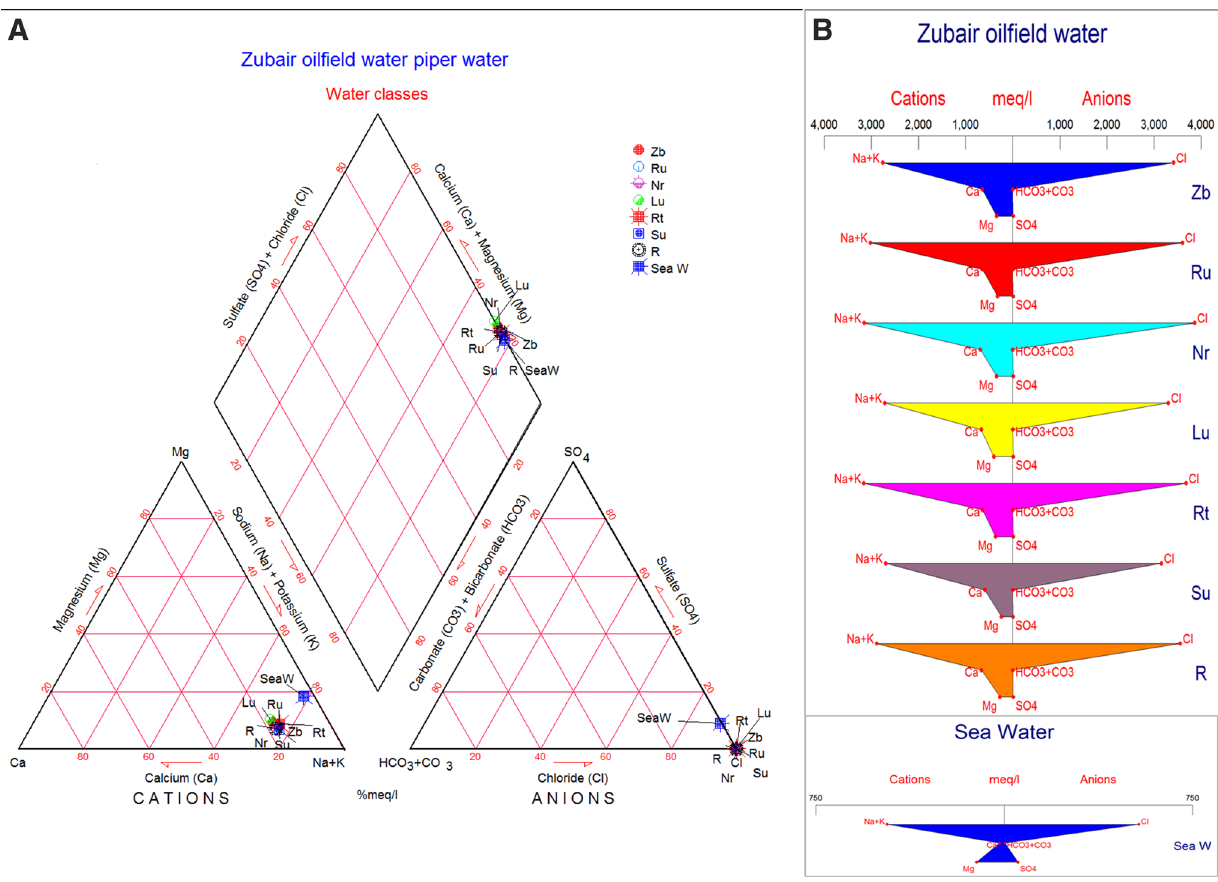
Fig. 5 Brine water types depending on a piper classification and b stiff diagram Table 4 Mineral saturation index values of the Zubair brines in the oilfields studied